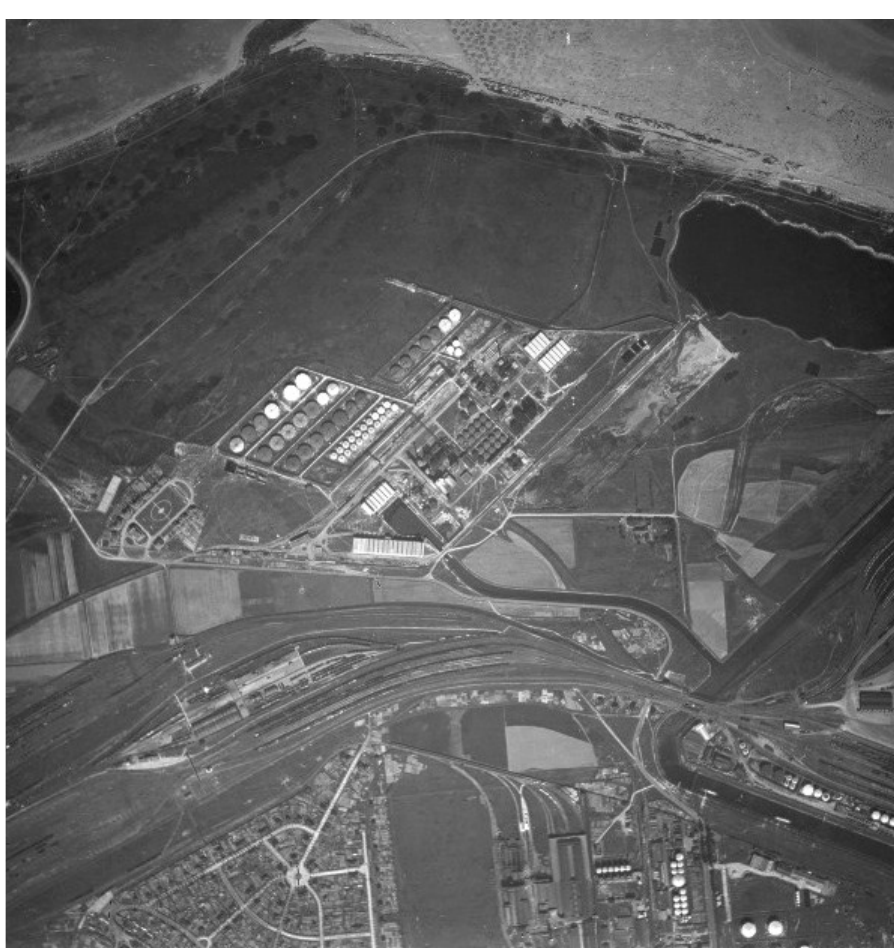
Figure 2. Aerial picture of the refinery Petrofina France, in 1936, later called refinery BP for British Petroleum, the company owning the facility. The Cité des Ingénieurs is on the southwest territory of the refining complex. Source: IGN (n.d.). industrial port cities with the creation of spaces between port and city territories that served as buffer zones.